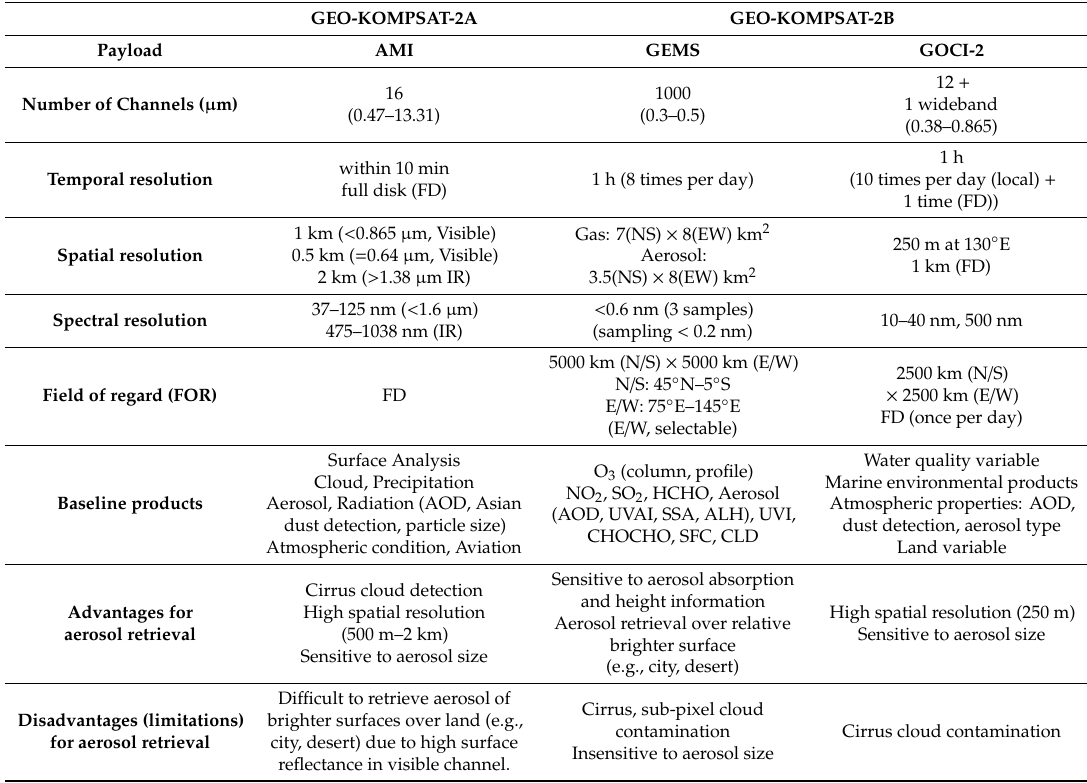
Table 1. Specifications of Advanced Meteorological Imager (AMI), Geostationary Environment Monitoring Satellite (GEMS), and Geostationary Ocean Color Imager-2 (GOCI-2)